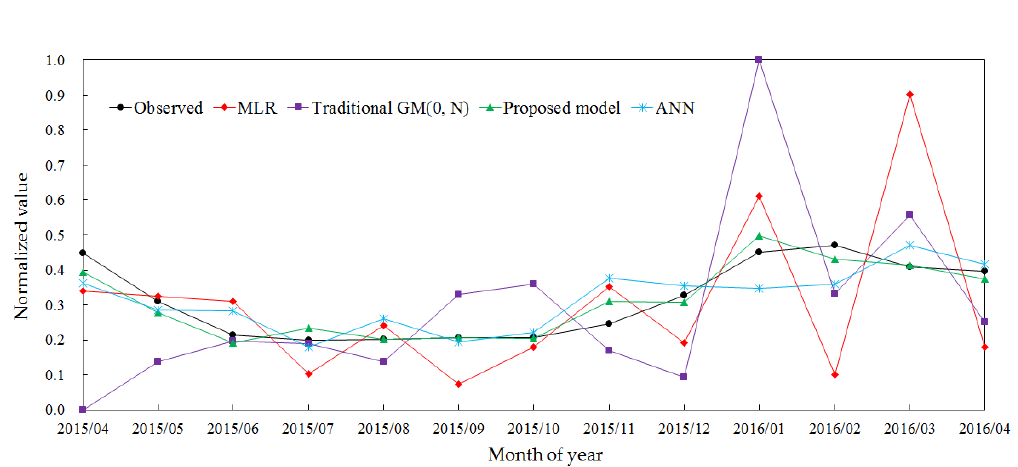
Figure 10. Forecasting results of different models from April 2015–April 2016.